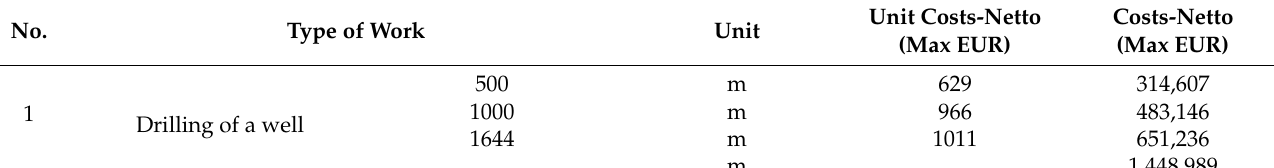
Table 10. Net costs of drilling work for the MroczkiMałe/S˛edzimirowice locations